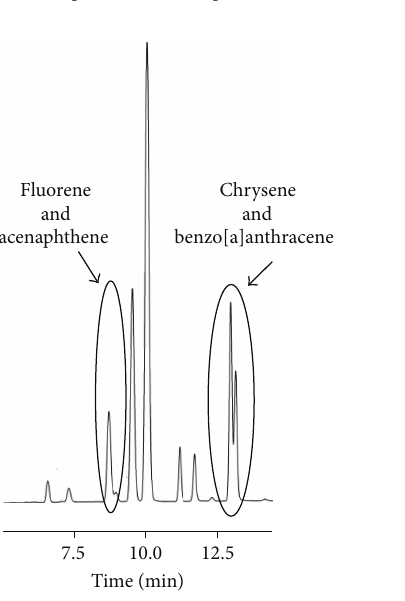
Figure 1: Example of coeluting peaks between fluorene/acenaph- thene and chrysene/benzo[a]anthracene in the analysis of